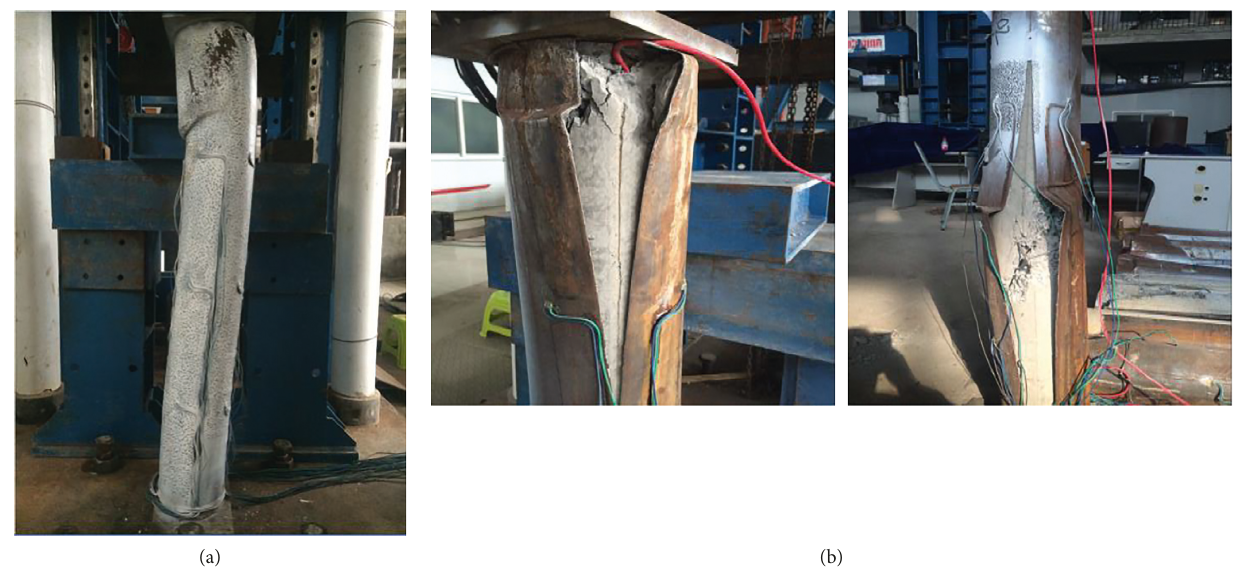
Figure 6: Failure modes of reinforced CFST pile. (a) Buckling deformation. (b) Splitting of the steel casing weld.